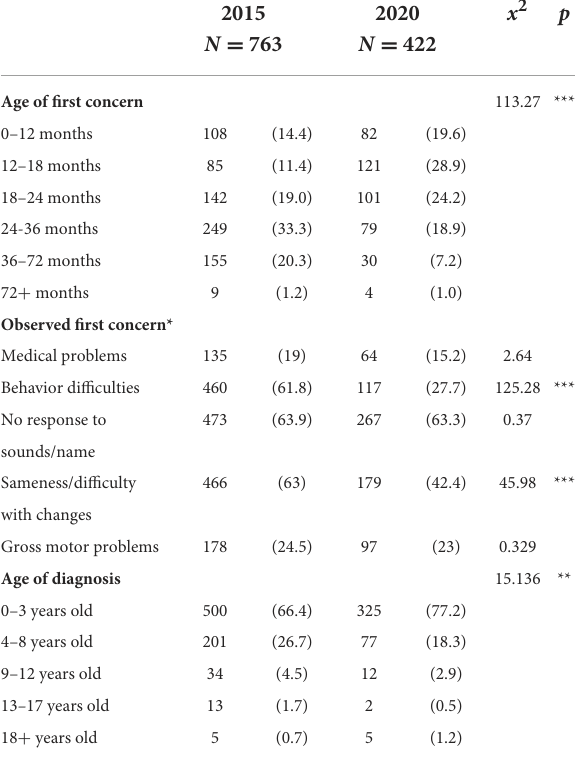
TABLE 2 First developmental concern and age of diagnosis.